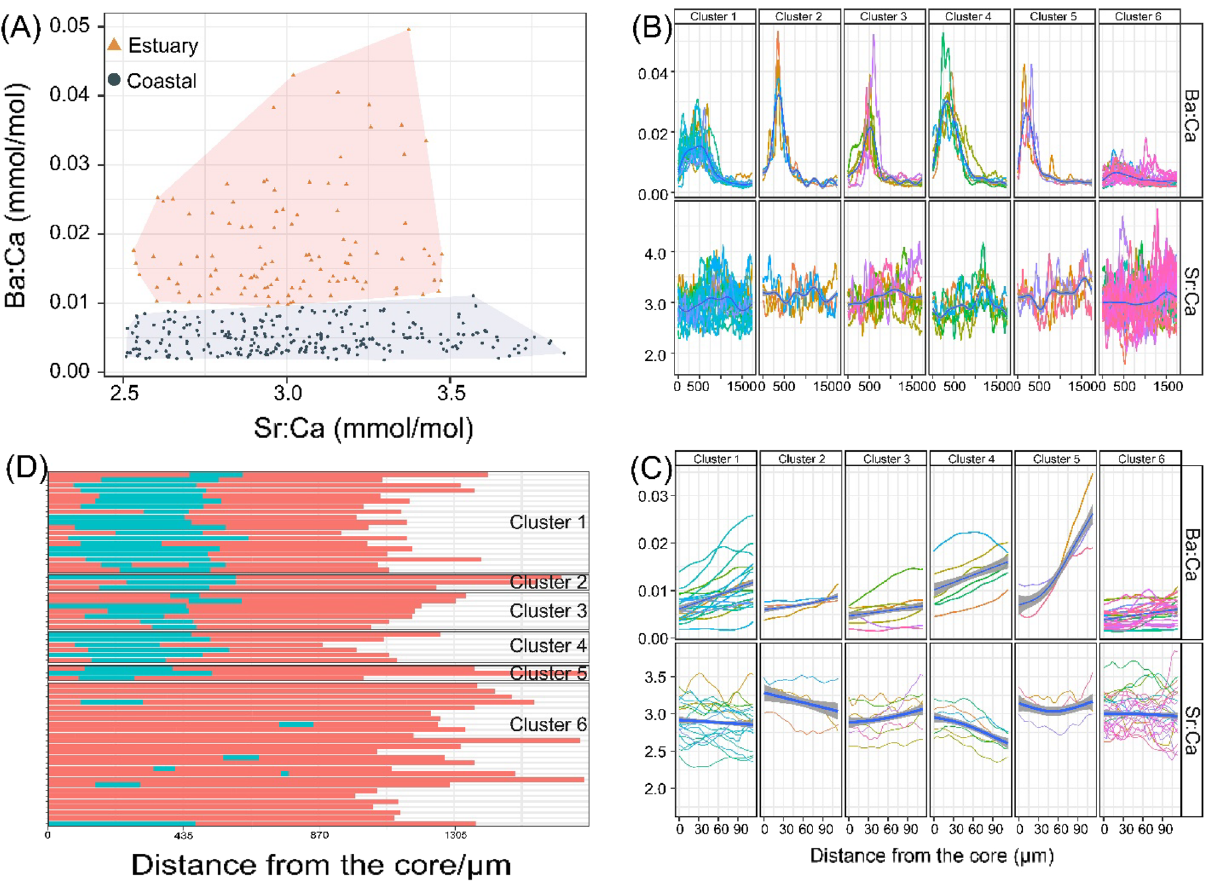
Figure 5. ( A ) Clustering of all of the otolith segments based on Sr:Ca and Ba:Ca elemental signatures of fourfinger threadfin collected in South China. ( B ) Partitional clustering based on Ba:Ca and Sr:Ca transects with dynamic time warping distance. Blue lines represent the fitted values by GAM. ( C ) The Ba:Ca and Sr:Ca data along otolith growth axes for larvae stage. ( D ) Individual life sequences of fourfinger threadfin inferred from the otolith elemental signatures (n = 64). Red bar: fish living in coastal habitat; blue bars: fish living in estuarine habitat. Samples were grouped according to the clusters shown in (Fig. 5B, n = 7), Cluster 4 (Fig. 5B, n = 6) and Cluster 5 (Fig. 5B, n = 19) contained individuals with a high Ba:Ca signal peak in their early life history, and the Ba:Ca dropped to a lower level although they started to decline at different times. The high Ba:Ca peak corresponded to the segments assigned into estuary habitat, indicating that these fish were reared in brackish or even in oligohaline waters (e.g., ‘estuarine-dependent’). Cluster 6 (Fig. 5B, n = 26) included fish featured with consistently low Ba:Ca ratios, and their profile segments were mainly assigned into the coastal habitat (i.e., ‘coastal-residents’ life history pattern). To show the details of the early life history stage (hatching to about 15–20 days), the first 120 μm of the element profiles was further separated (Fig. 5C). The fish of Cluster 1, 4 and 5 displayed a generally fast growth Ba:Ca ratios in larvae stage, in contrast to the relatively stable Ba:Ca ratios in Cluster 2, 3 and 6. The time-at-transition from MRT were visualized by life sequences for each sample, and were grouped by life history clusters (Fig. 5D). Proportion of E. tetradactylum moving between different types of habitat environ- ment were over 63.6%. Among all the fish samples, 12.1% of their first segment of profile was assigned into lower estuary habitat, and 19.7% of the samples had some segments that were assigned into upper estuary habitat. The experience of estuarine environments dominantly occurred in early life history stages, except the two samples of Cluster 6 (ZJ01 and ZJ31), which were considered to enter into estuary habitat at the beginning of the second half of life history. Population structure. For the larval stage, the overall differences in mean elemental ratios among sampling locations were not significant (PERMANOVA, p > 0.05). Pairwise comparisons also showed no multivariate sig- nificant difference between any sampling locations pair. For single element, Li:Ca, Na:Ca, Mg:Ca, Mn:Ca and Sr:Ca ratios did not show significant differences (Kruskal–Wallis test; p > 0.05). Cu:Ca and Ba:Ca only showed highly significant differences among few locations (Kruskal–Wallis test, p < 0.05) (Fig. 6A). Between the different clusters of life sequences, at the larval stage, the overall differences in mean elemen- tal ratios among sampling locations were also not significant (PERMANOVA, p > 0.05). Pairwise comparisons showed no multivariate significant difference between any clusters. For single element, Li:Ca, Na:Ca, Mg:Ca,